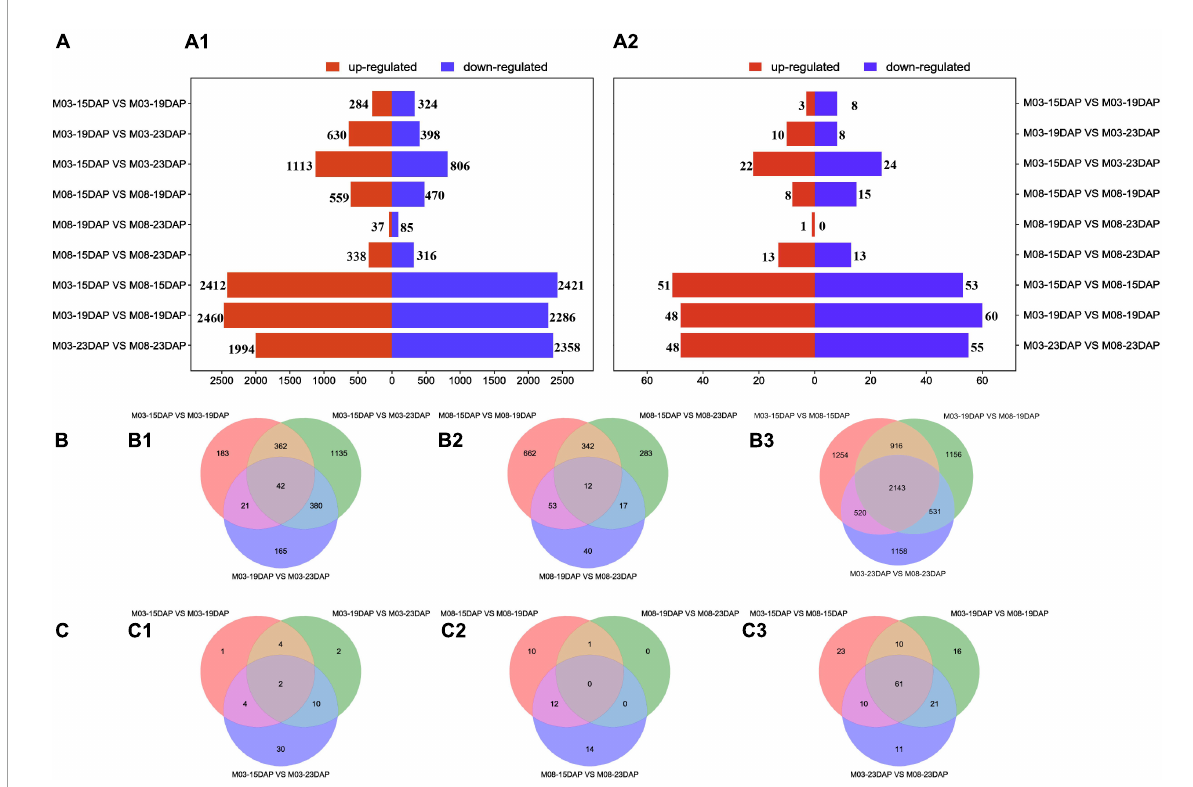
FIGURE2 Differentially expressed genes and miRNAs at different stages during kernel development. (A) The numbers of upregulated and downregulated DEGs (A1) and DEMIs (A2) in the different comparison groups. (B) Venn diagrams of DEGs in the M03 (B1) , M08 (B2) , and M03M08 (B3) groups. (C) Venn diagrams of DEMIs in the M03 (C1) , M08 (C2) , and M03M08 (C3)